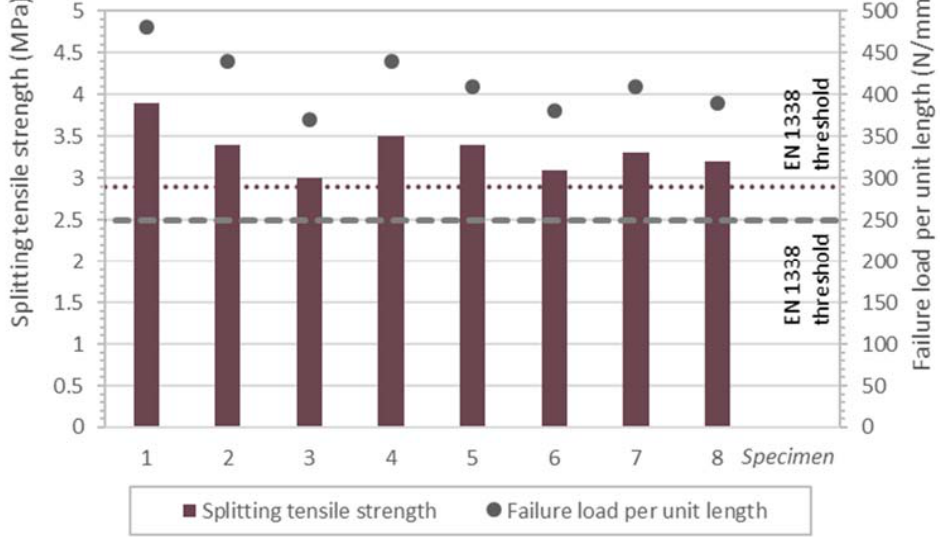
Figure 5. Splitting tensile strength in eight RACC paving blocks and minima specified in standard EN 1338.